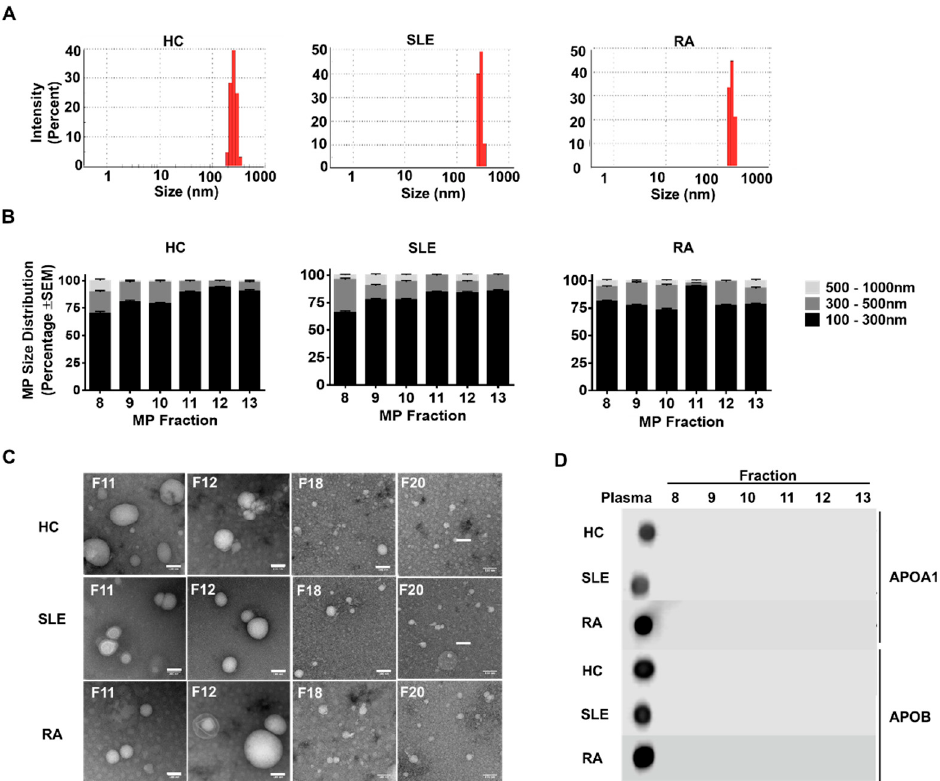
Figure 1. Microparticles from different groups share similar biophysical characteristics . ( A ) Representative sizing graphs from healthy control (HC), systemic lupus erythematosus (SLE) and rheumatoid arthritis (RA) microparticles (MP) using dynamic light scattering (DLS). The intensity (percentage) of particles present at a particular size was measured. In all cases, the size of particles in fractions 8–13 ranged from 100 to 1000 nm. ( B ) MP size distribution as determined by DLS. In all cases, the majority ( > 60%) of MP present in fractions 8–13 were between 100 and 300 nm (black bar), with approximately 25% of MP being between 300 and 500 nm in size (dark grey bar) and the remainder falling into the 500–1000 nm sizing bracket (light grey bar). Data are expressed as mean + SEM. ( C ) Representative TEM images from HC, SLE an RA fractions 11, 12, 18 and 20. In all cases, generally, particles ≥ 100 nm in size are evident in fractions F11 and 12 and not in later fractions 18 and 20. Scale bar = 100 nm. ( D ) Lack of APOA1 and APOB immunoreactivity in fractions 8–13. Plasma was used as a positive control.